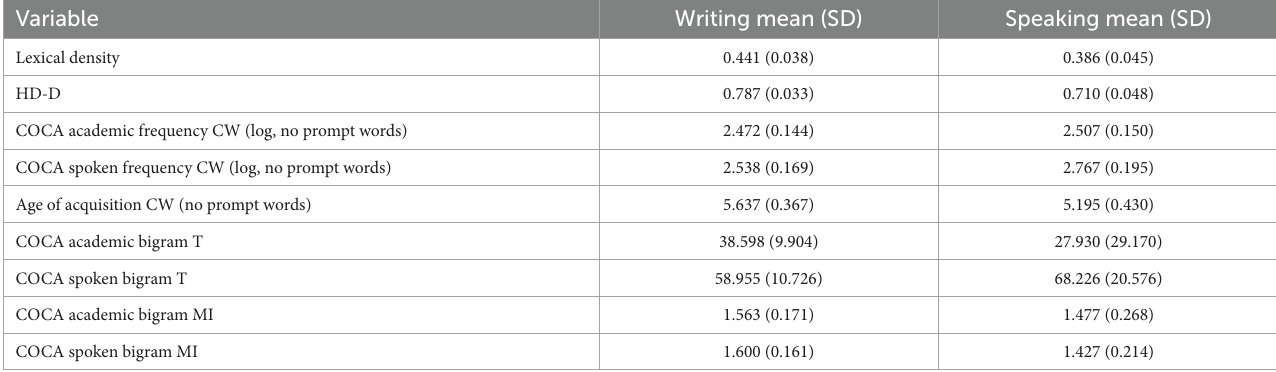
TABLE 1 Descriptive statistics for lexical and phraseological features found in L2 written and spoken responses.